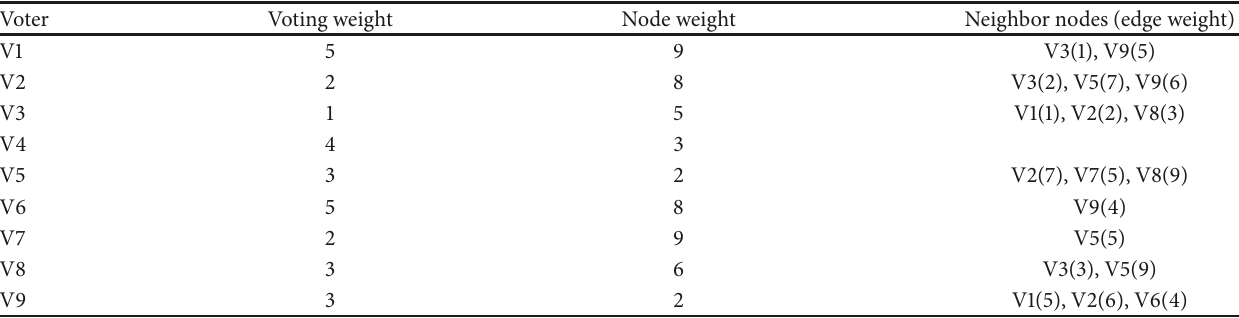
Table 1: Voting weight and voters’ social information.